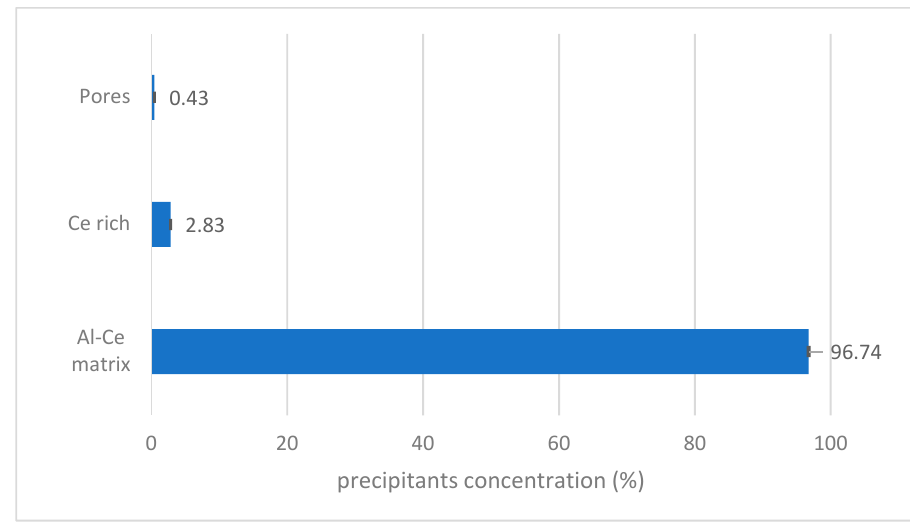
Figure A4. PIT Al-14Ce wt % precipitants concentration.